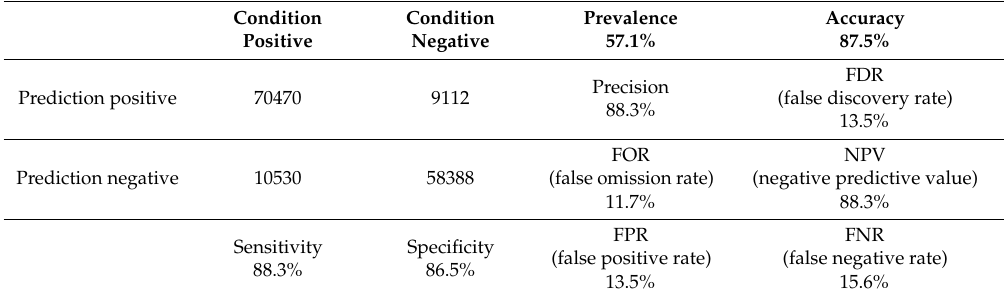
Table 2. Confusion matrix for single spectrum LSVM classification (~300 variables).